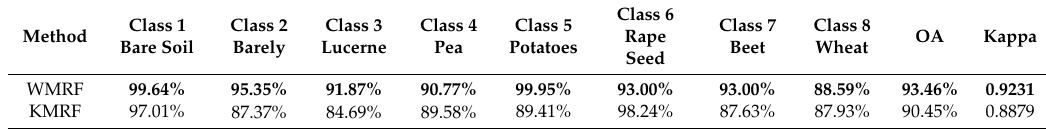
Table 3. Comparison of the region-based classification algorithms for the Flevoland data.